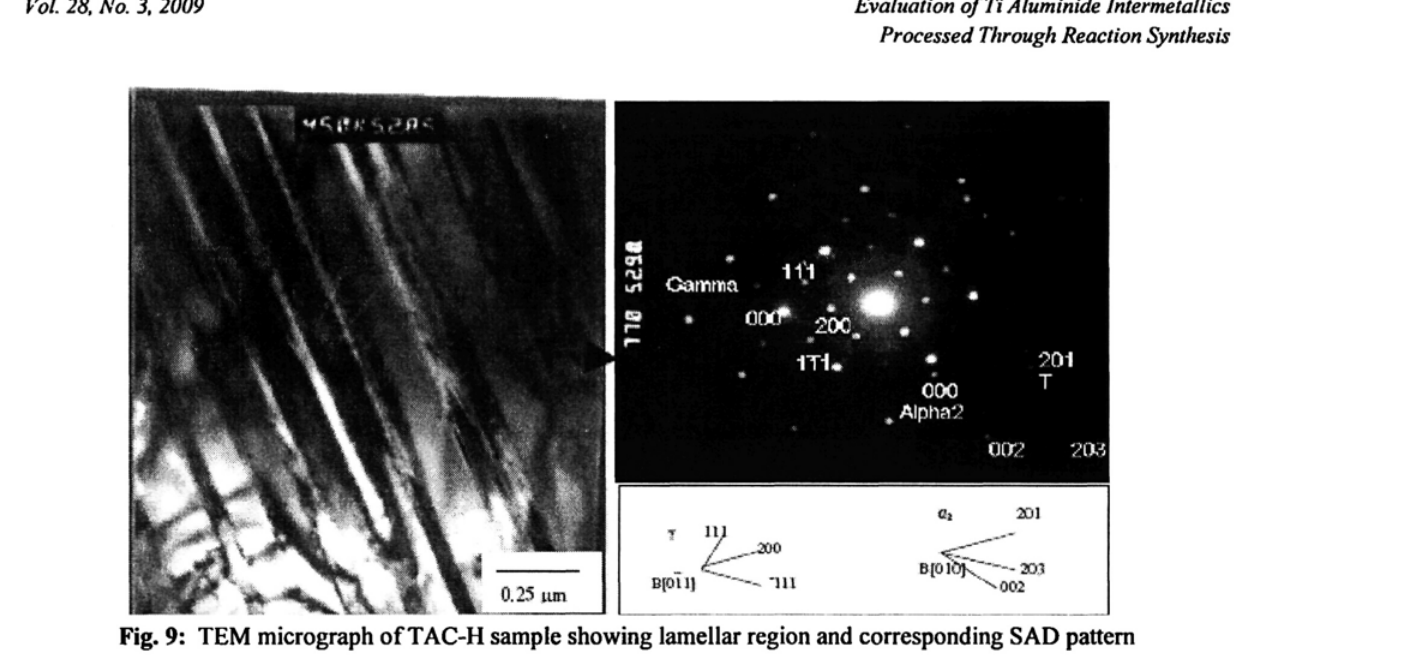
Fig. 9: TEM micrograph of TAC-H sample showing lamellar region and corresponding SAD pattern